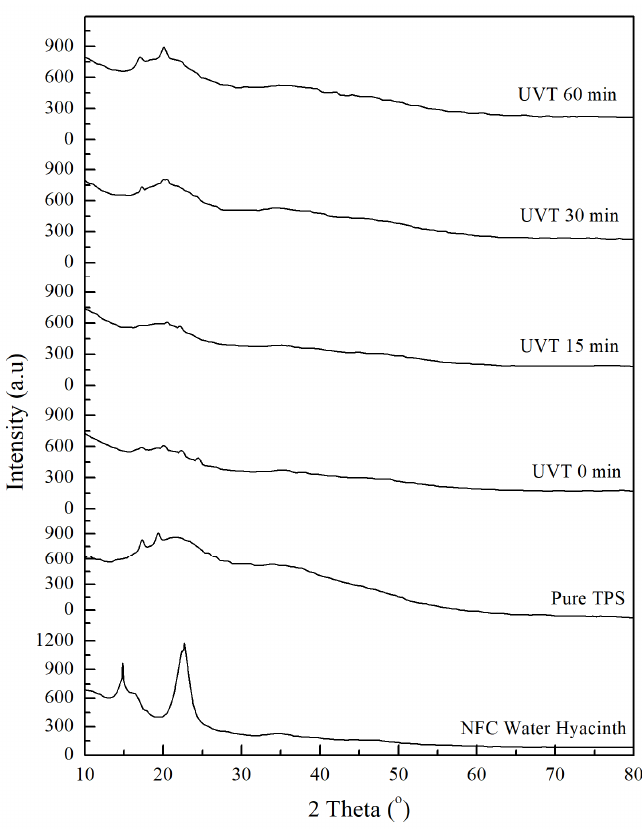
Figure 4. XRD pattern of all samples tested.